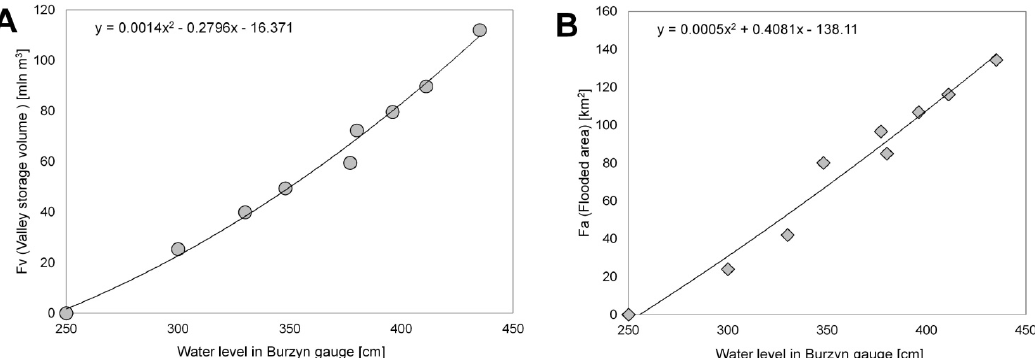
Figure 5. ( A ) Relation between water level of Biebrza (Burzyn gauge) and the volume of flood in the Lower Biebrza Basin; ( B ) Relation between water level of Biebrza (Burzyn gauge) and the area of flood in the Lower Biebrza Basin (stretch of the valley between Osowiec water gauge and Burzyn water